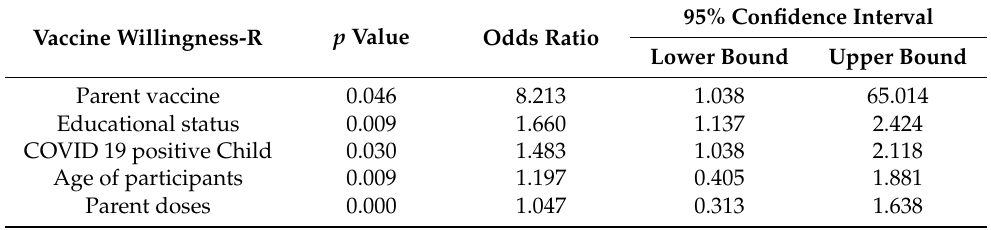
Table 9. Multinomial regression